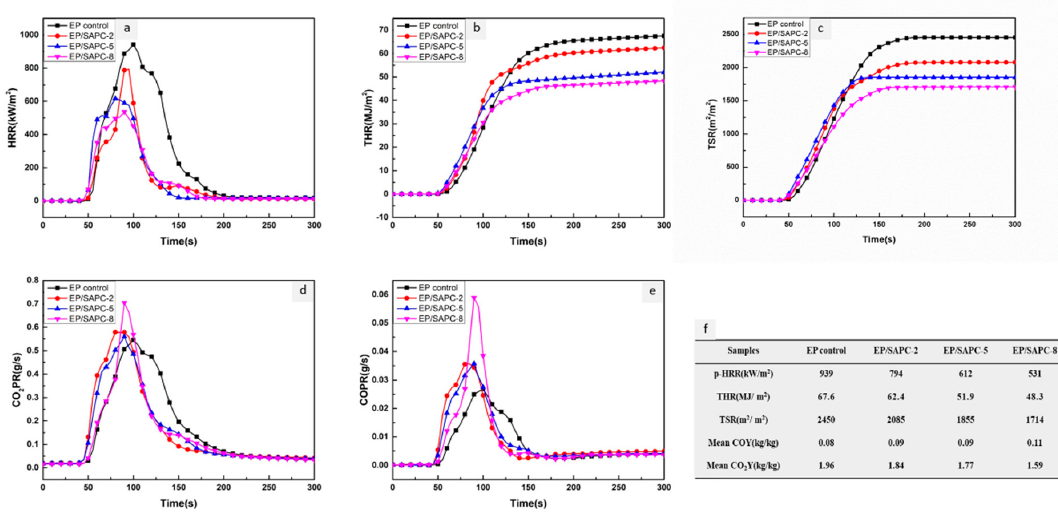
Figure 6. ( a ) Heat release rate (HRR); ( b ) total heat release (THR); ( c ) total smoke release (TSR); ( d ) CO 2 production release rate (CO 2 PR) curves; ( e ) CO production release rate (COPR) curves; ( f )